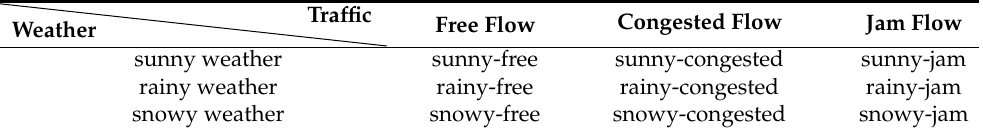
Figure 3. The driver’s vision. Table 1. Driving simulation scenarios.